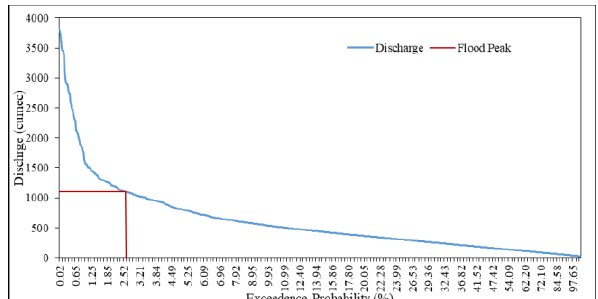
Figure 21 Exceedance probability curve at Nadaun (ERA-